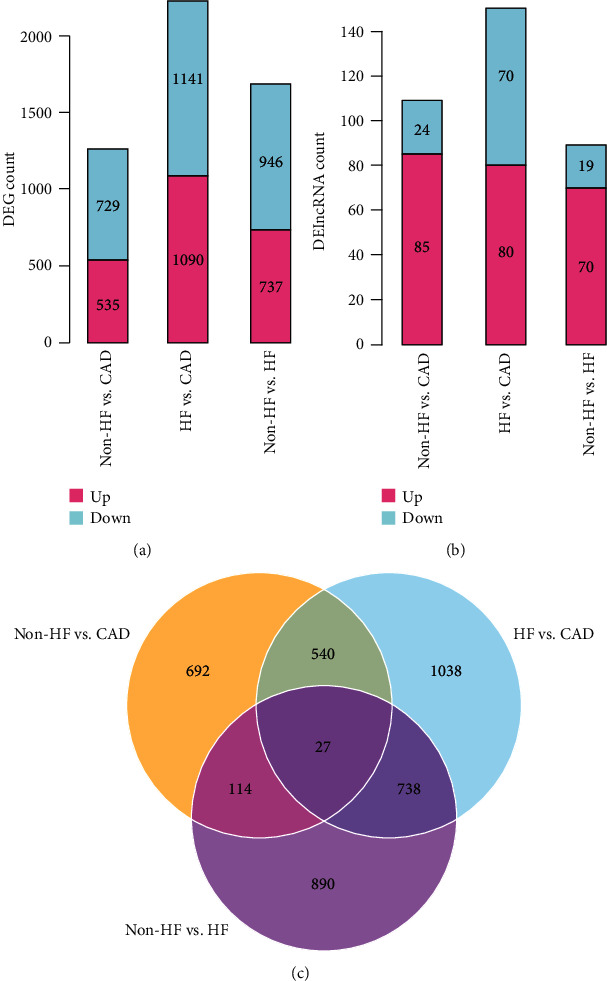
The DEGs (a) and DElncRNAs (b) in each comparison showed significant differences in the direction distribution of the histogram. (c) The Venn diagram was compared between the two groups.